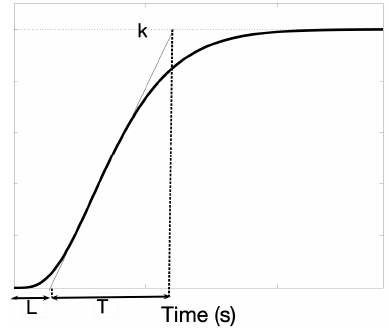
Figure 3. S-shaped response.